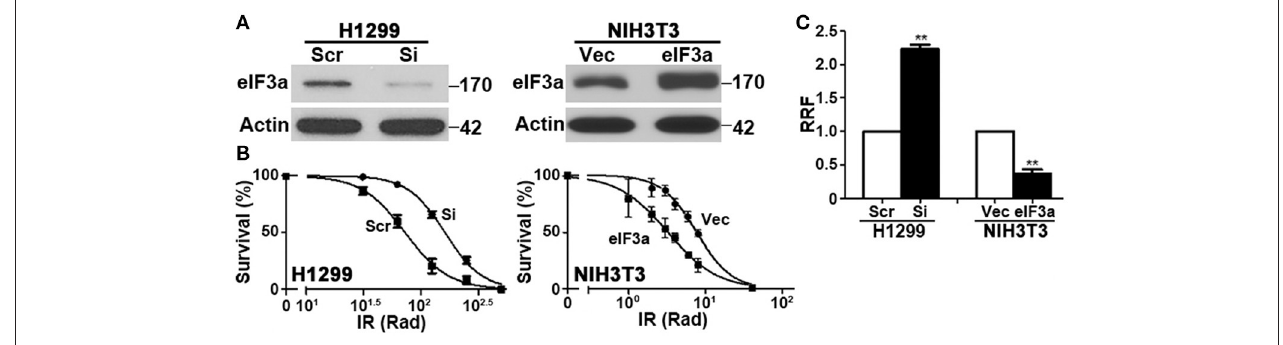
FIGURE 1 | Effect of eukaryotic initiation factor (eIF)3a expression on the cellular response to ionizing radiation (IR). Western blot analyses (A) and colony formation assay following IR treatment (B) of H1299 cells with transient eIF3a knockdown and NIH3T3 cells with stable eIF3a overexpression compared with their respective control cells. Actin was used as a loading control. Panel (C) shows a summary of eIF3a effects on cellular sensitivity to IR treatments. Relative resistance factor (RRF) was derived by dividing the IC 50 of the test cells by that of their control cells ( n = 3, ** P < 0.01).